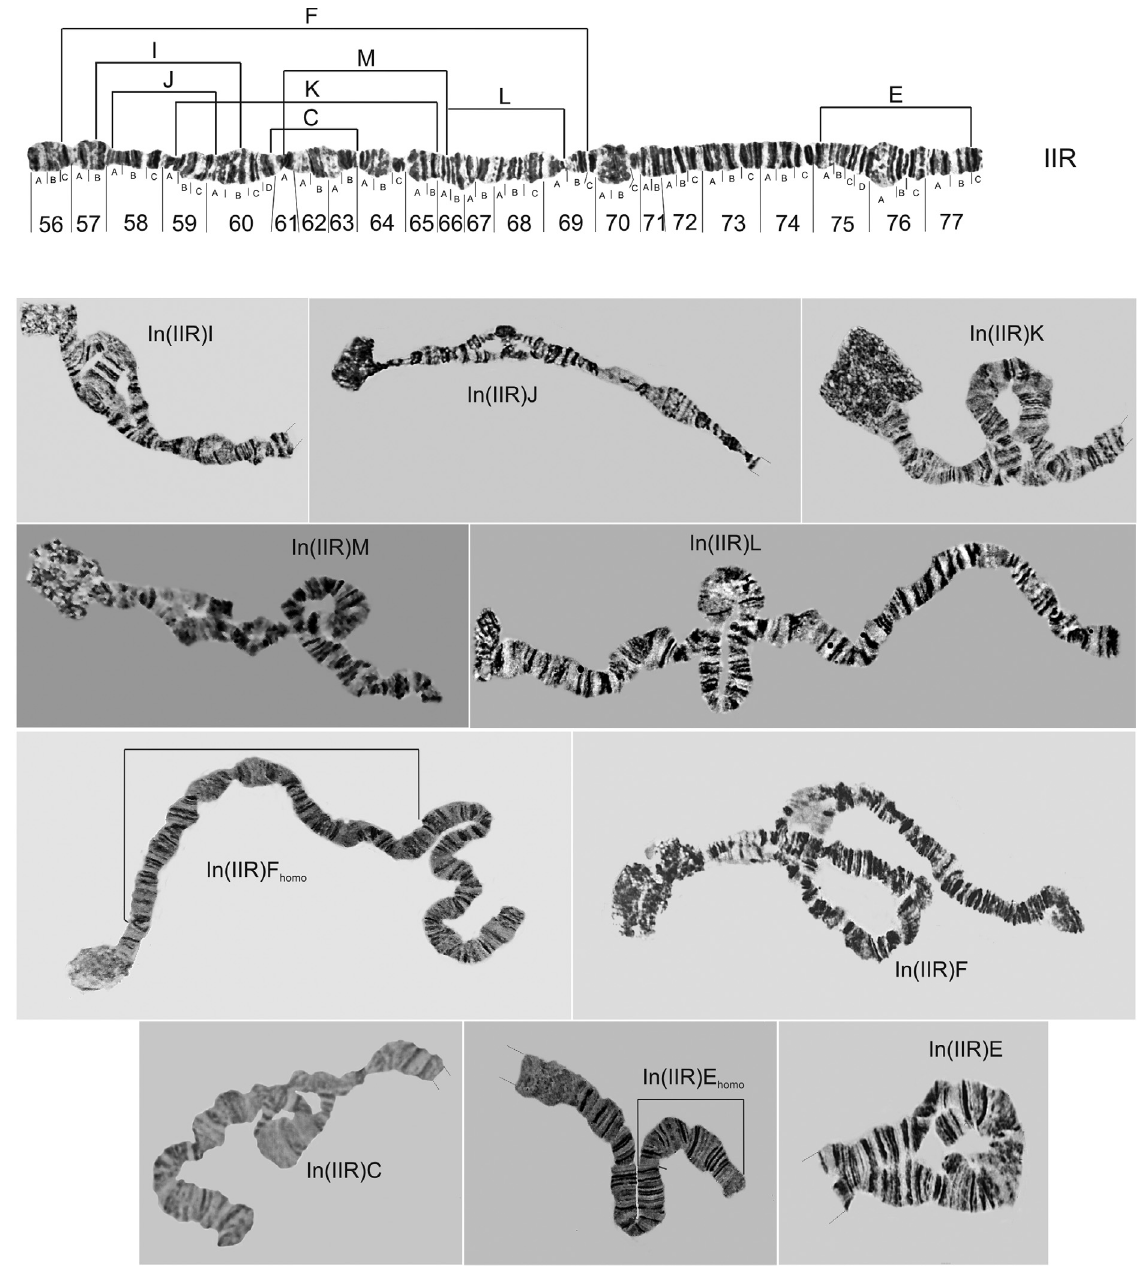
Figure4 -DistributionofinversionbreakpointsobservedonchromosomalarmIIRof D.willistoni andphotomicrographsofinversions(inhomoandhet- erozygous state)